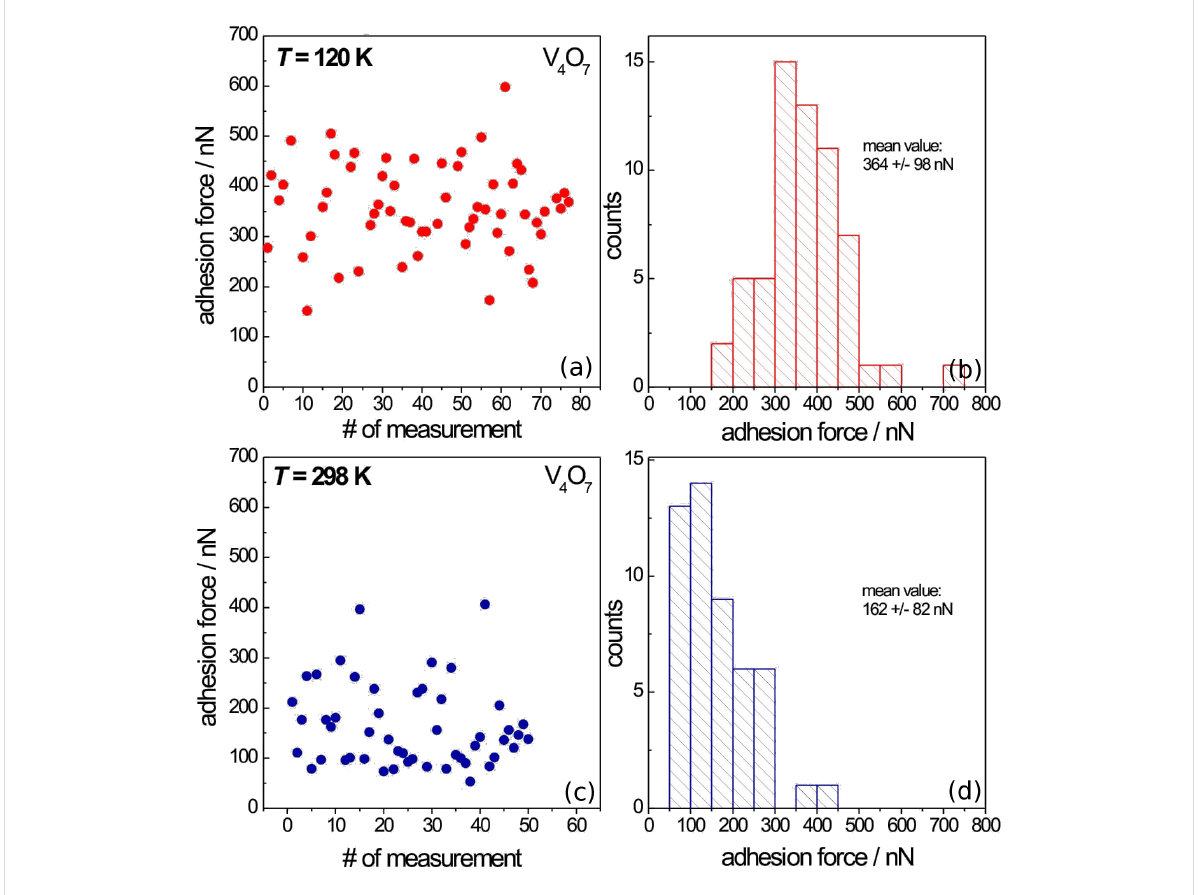
Figure 4: Statistical analysis of the adhesion forces acquired at the V 4 O 7 cleavage plane at (a, b) 120 K and (c, d) 298 K. Displayed are (a, c) the sequences of data points acquired at different surface spots and (b, d) the normalized frequency distributions. The numbers given are the data aver- ages and their standard deviations.